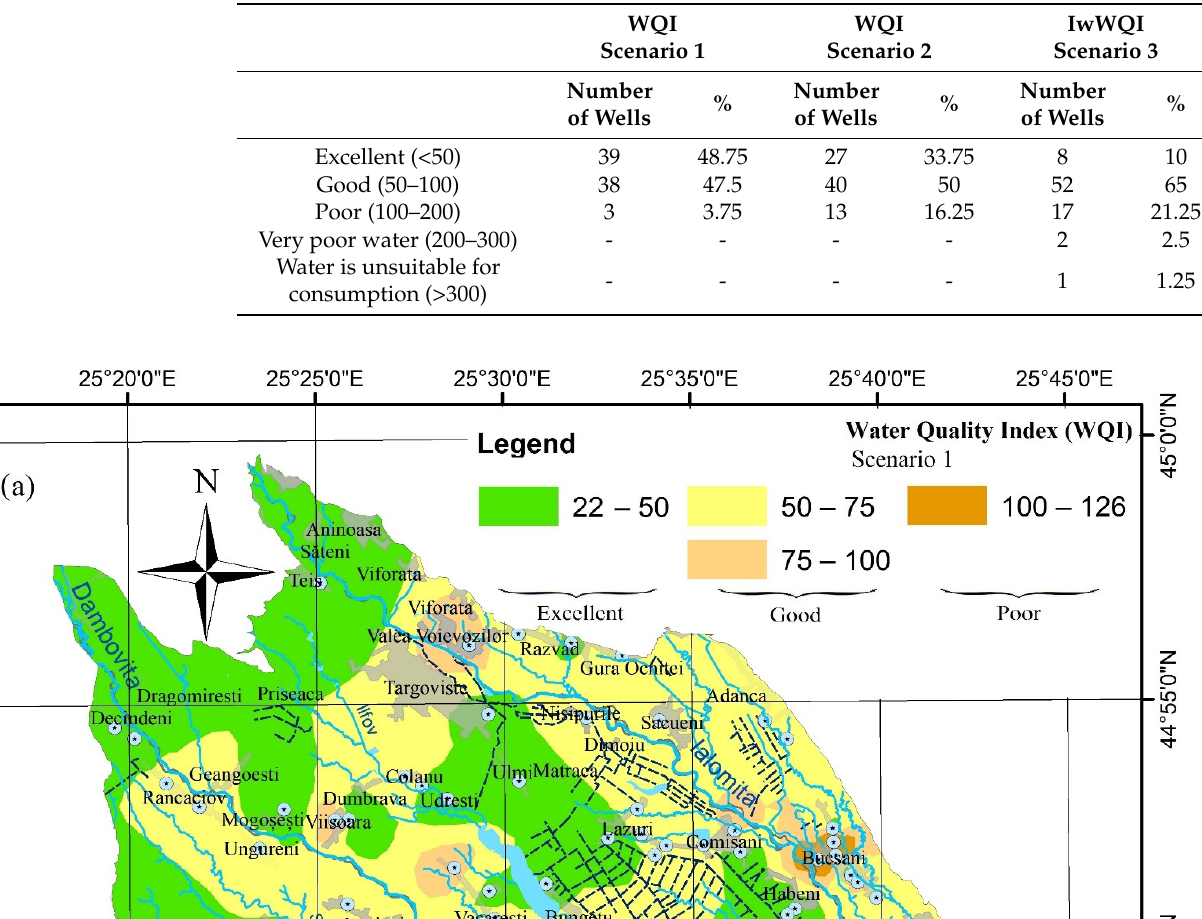
Table 4. Number of wells depending on the class of